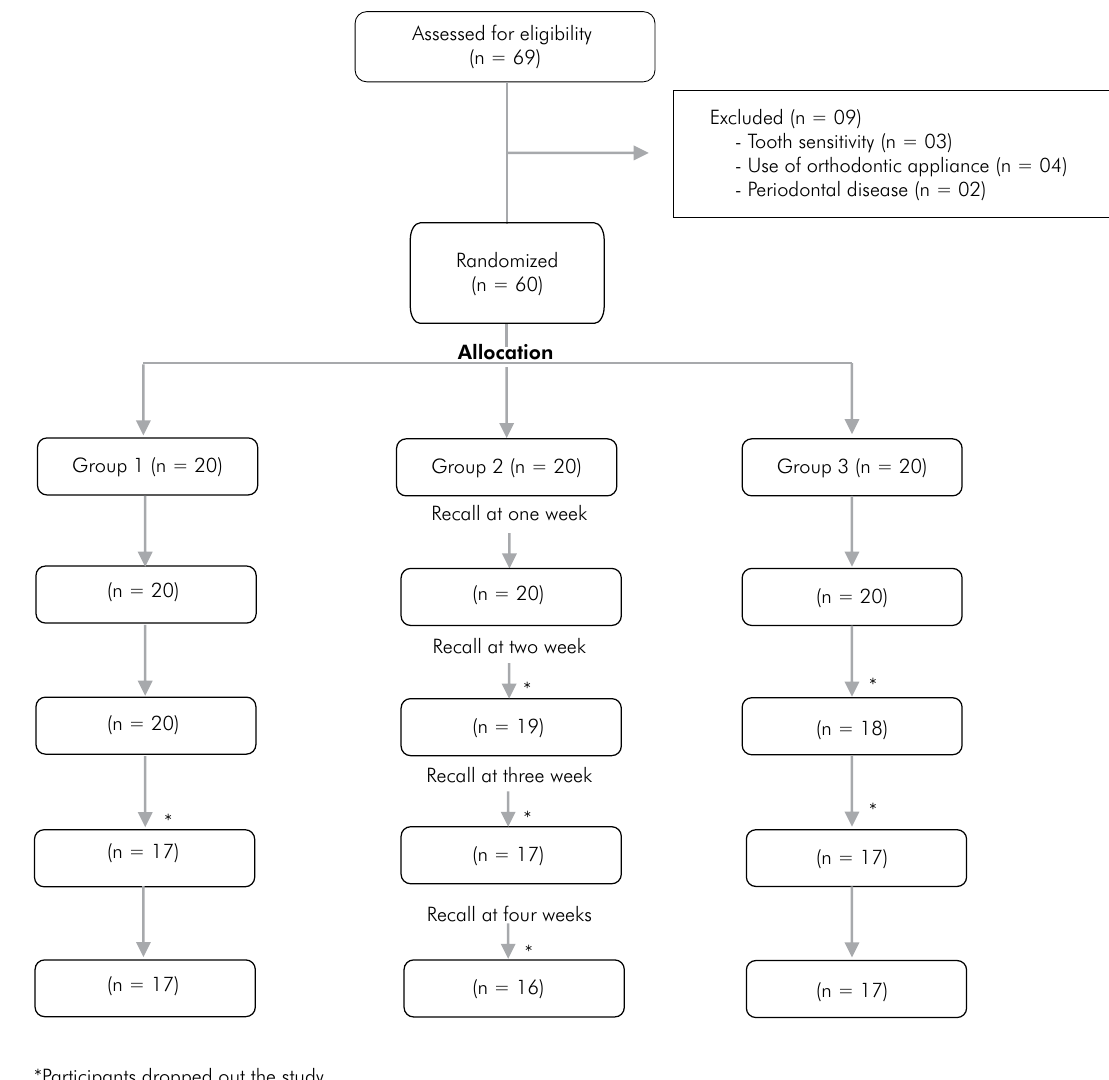
Figure 1. The consort flow